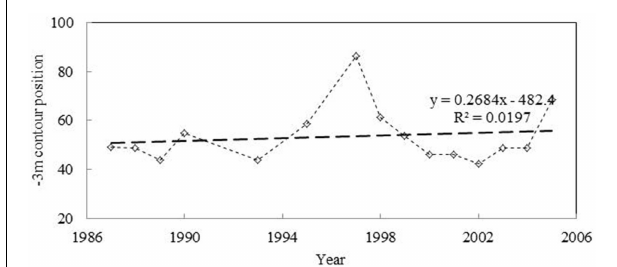
FIGURE 9 | Average annual shoreline position at OWO pier at J-O Coast.